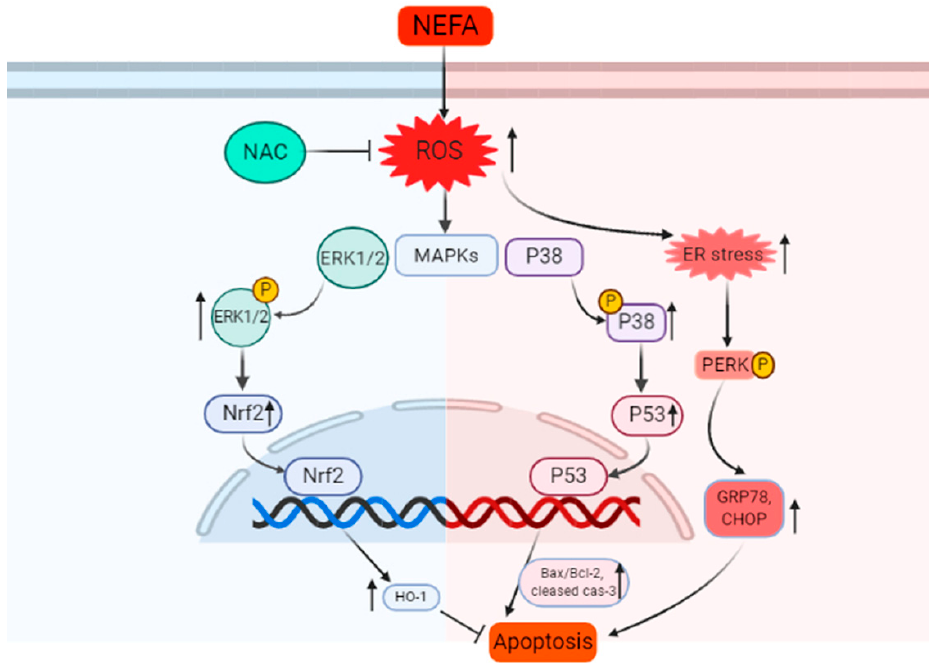
Figure 8. The potential molecular mechanism of NEFA inducing apoptosis in GCs. NEFA induced ROS accumulation, endoplasmic reticulum stress, and apoptosis in granulosa cells. The addition of antioxidant NAC proved that the ROS mediated apoptosis induced by NEFA was regulated by Nrf2/HO-1 and p53/Bax pathway.